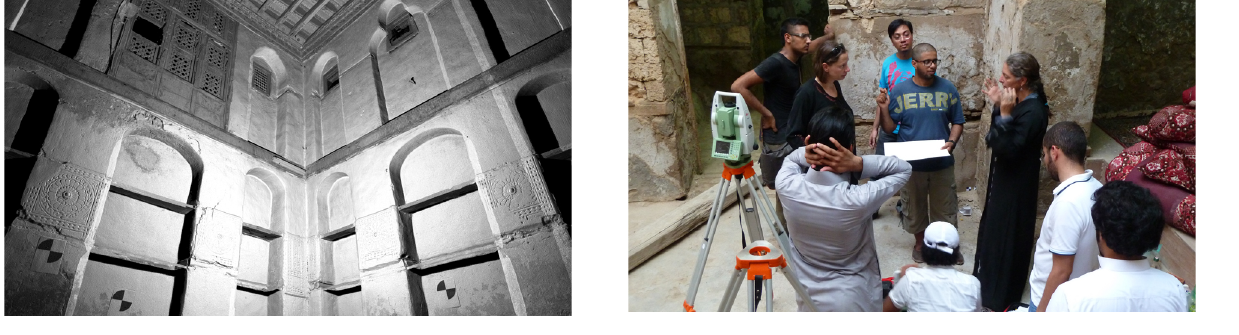
Figure 5 3D Laser scan of the Al Nawar house Figure 5 An unusual picture for Saudi